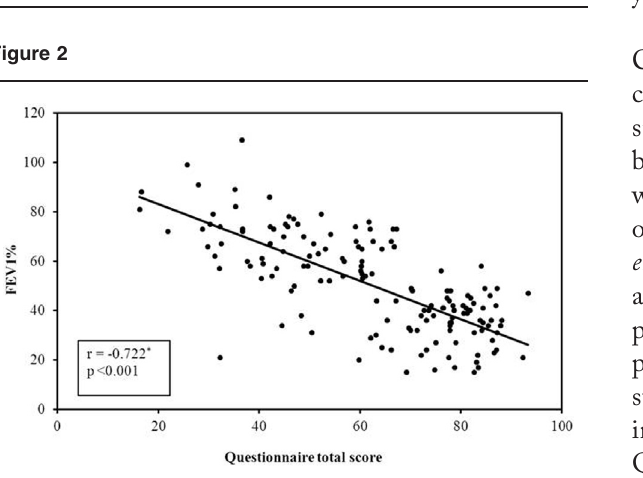
Correlation between age and St George ’ s Respiratory Questionnaire.